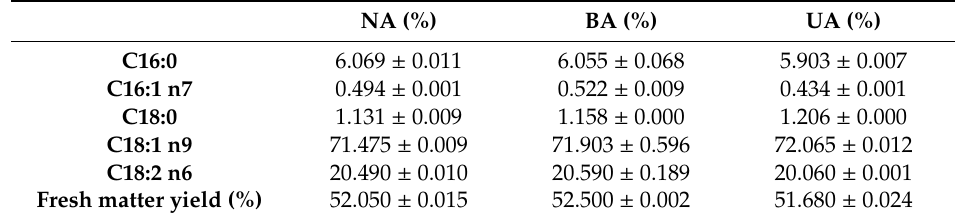
Table 3. Relative percentages of NA, BA and UA oil – GC analysis and oil yields – Soxhlet